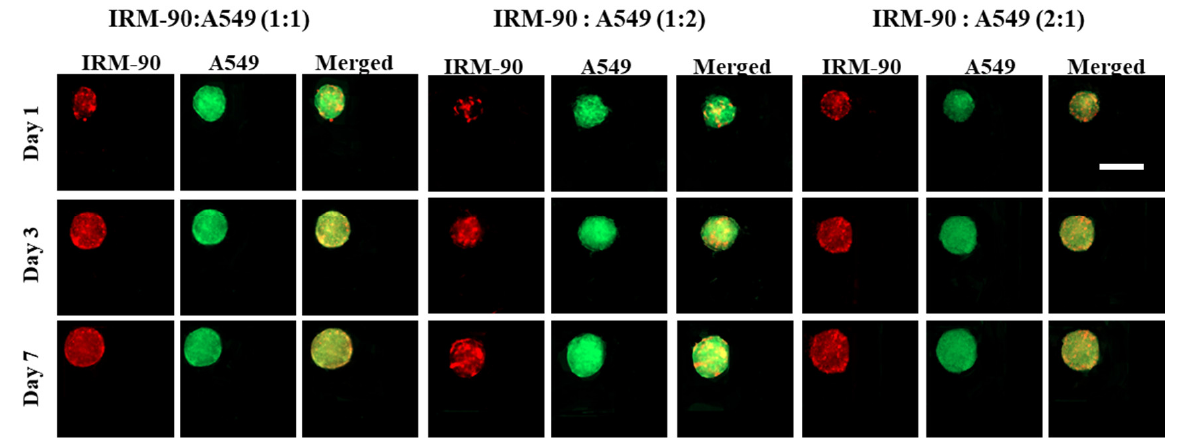
Figure 5. Image of co-culture A549 and IRM-90 cells with different ratios between the two cell lines. The total initial cell concentration was 1 × 10 6 cells/mL for all experiments. Our observations demonstrated that there were no remarkable differences in terms of the growth pattern including the size and the shape of the spheroids by varying the ratio between tumor and stromal cells. The red color is due to red-fluorescent protein (RFP) in IRM-90 cells and the green color is due to being fluorescently labeled with cell-labeling solution Vybrant Dio V22886 for A549 cells. Scale bars: 200 μm.